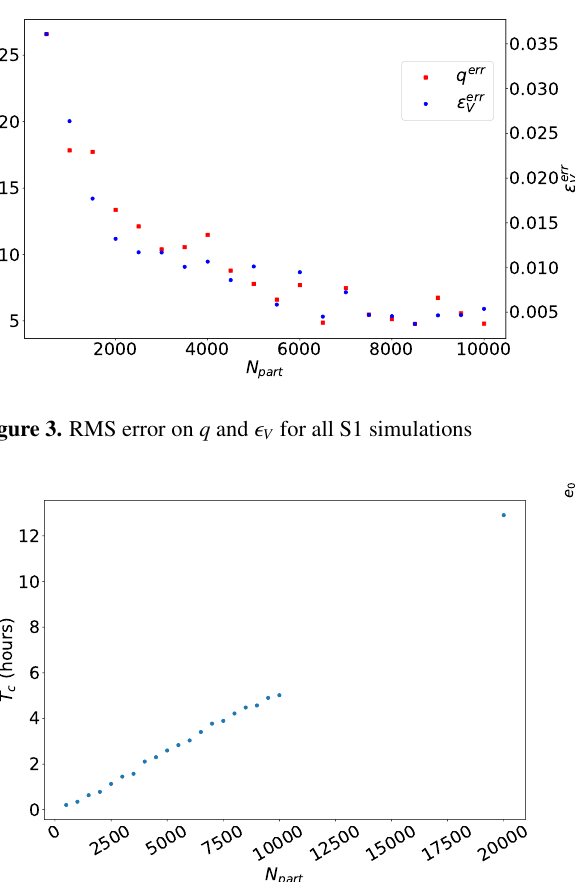
The volumetric strain (cid:15) V is defined as the trace of the true strain tensor. The RMS error based on Equation (4) was plotted for q and (cid:15) V on Figure 3. One can see that q err are decreasing for N part ≤ 7 , 000 and then pro- and (cid:15) err V